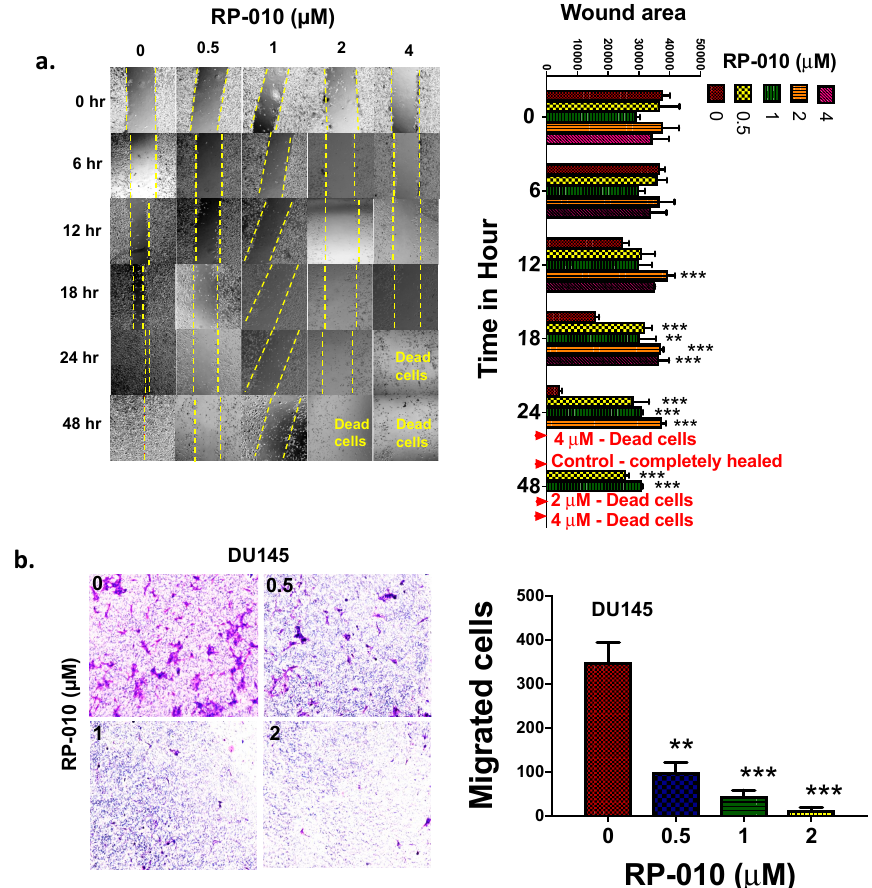
(Figure S6). Similar to DU145 cells, the induced wound in PC-3 monolayers, incubated with vehicle only, closed completely within 48 h (Figure S6). Cancers 2019 , 11 , x